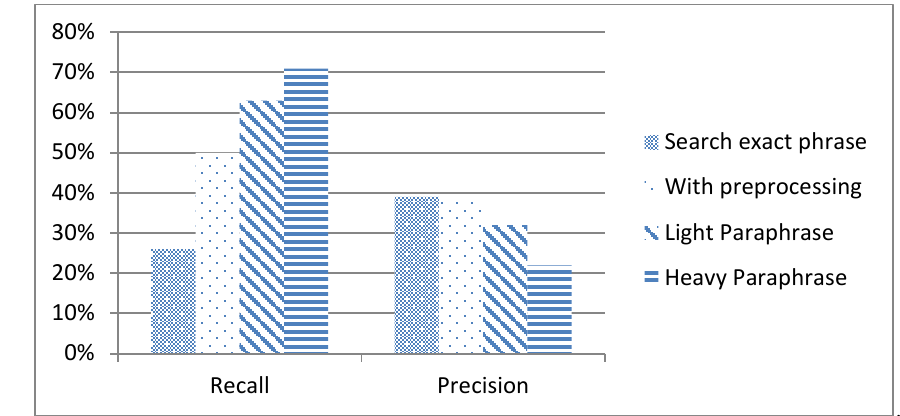
Figure 12. Evaluating ParaMaker in Persian language on TMC dataset.